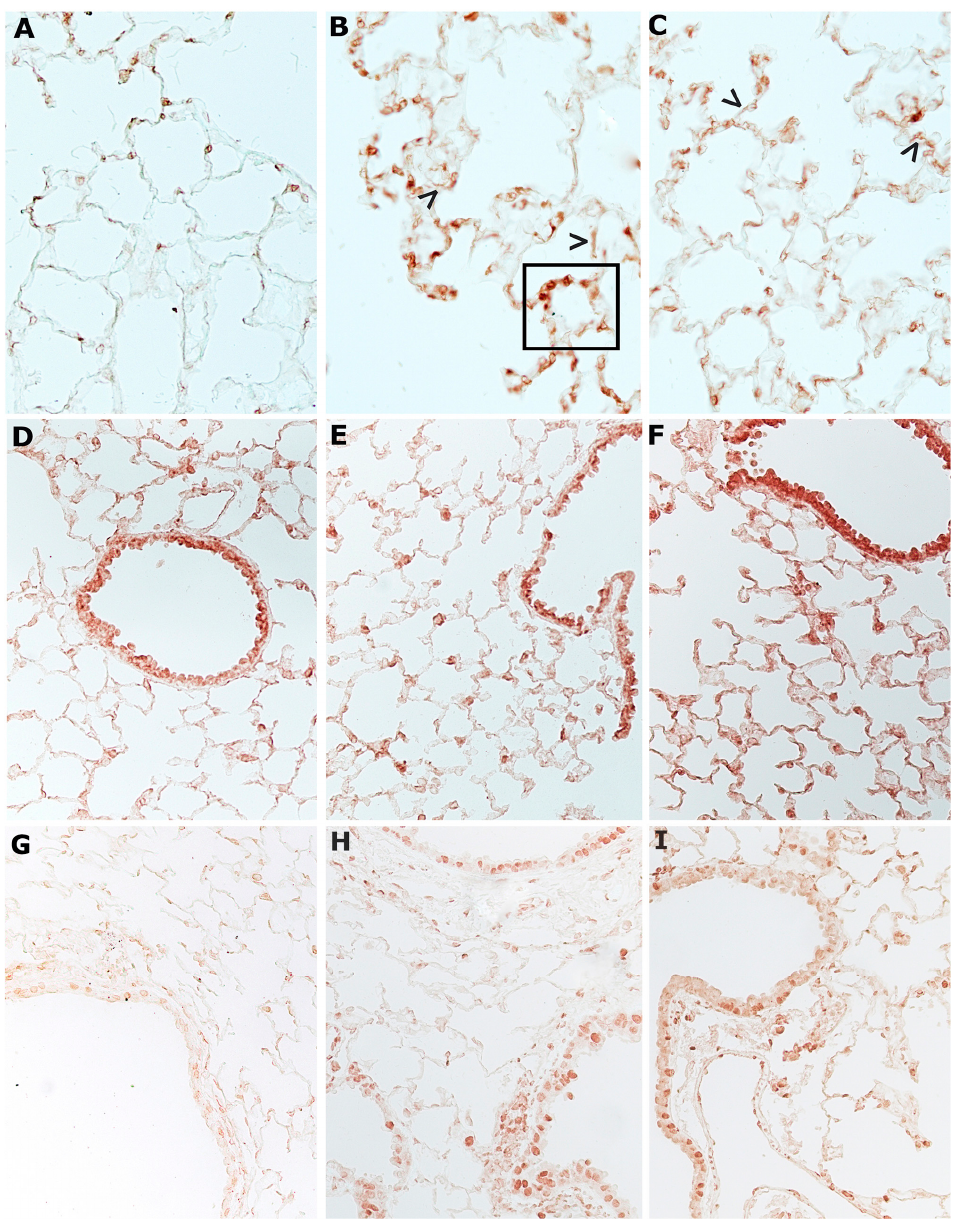
Figure 5. Neutrophil elastase (NE), metalloprotease 9 (MMP-9), and 8-oxo-7,8-dihydro-2 ′ -deoxy- guanosine (8-OHdG) after cigarette smoke: ( A ) Immunohistochemical staining for NE in air control lungs is visible only on the few neutrophils present inside the capillaries of the alveolar septa; ( B ) positive staining for NE is seen in the numerous neutrophils that are present throughout the lungs of smoking mice, much of the alveolar interstitium is positive for the immunohistochemical reaction for NE (>); ( C ) NE is seen on alveolar septa (>) and on the numerous neutrophils present inside and